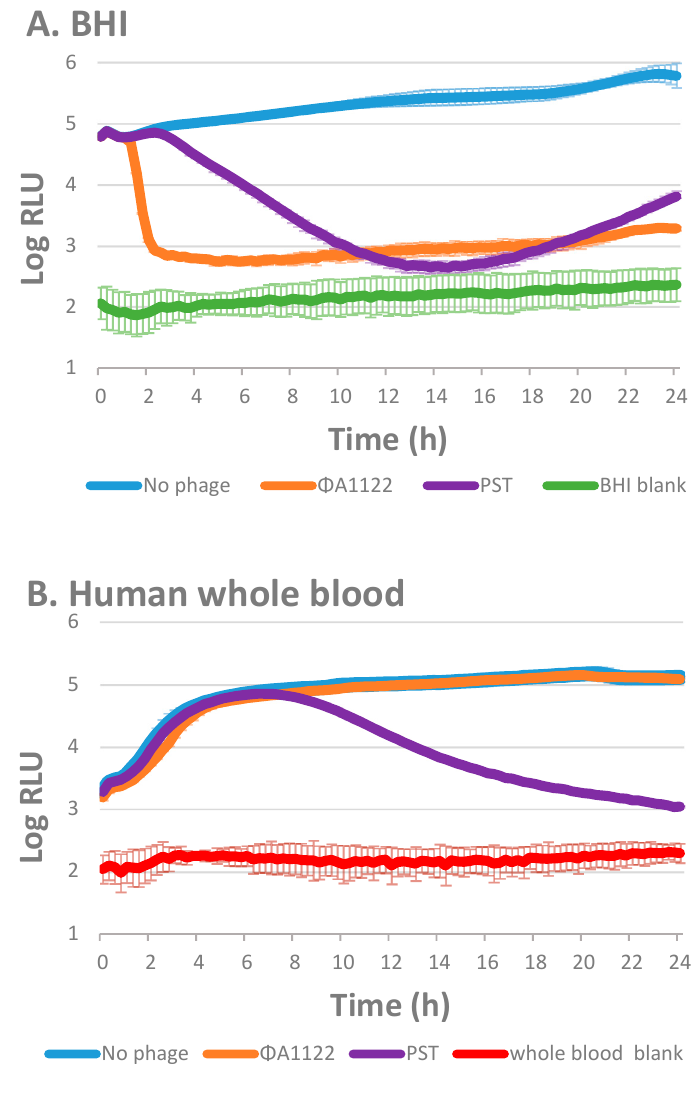
Figure 2. Phage lysis of EV76:: lux suspended in Brain Heart Infusion (BHI) or in whole blood. A bioluminescent lysis assay was performed with 90 µL of 10 7 CFU/mL EV76:: lux suspended in BHI ( A ) or in human whole blood ( B ) and infected with 10 µL of ϕ A1122 or PST phages (10 6 PFU/mL; MOI = 0.01). Bioluminescence was assessed by tracking the relative light units (RLU) at 37 °C in 15-min intervals for 24 h using a Spark 10 M plate reader. The experiment was performed using 10 different blood donors (of various blood types) and the results are representative of one blood donor (blood type O+, 9 days from uptake). Values are the average results from 3 wells triplicate in the same experiment, and the error bars represent the standard deviation